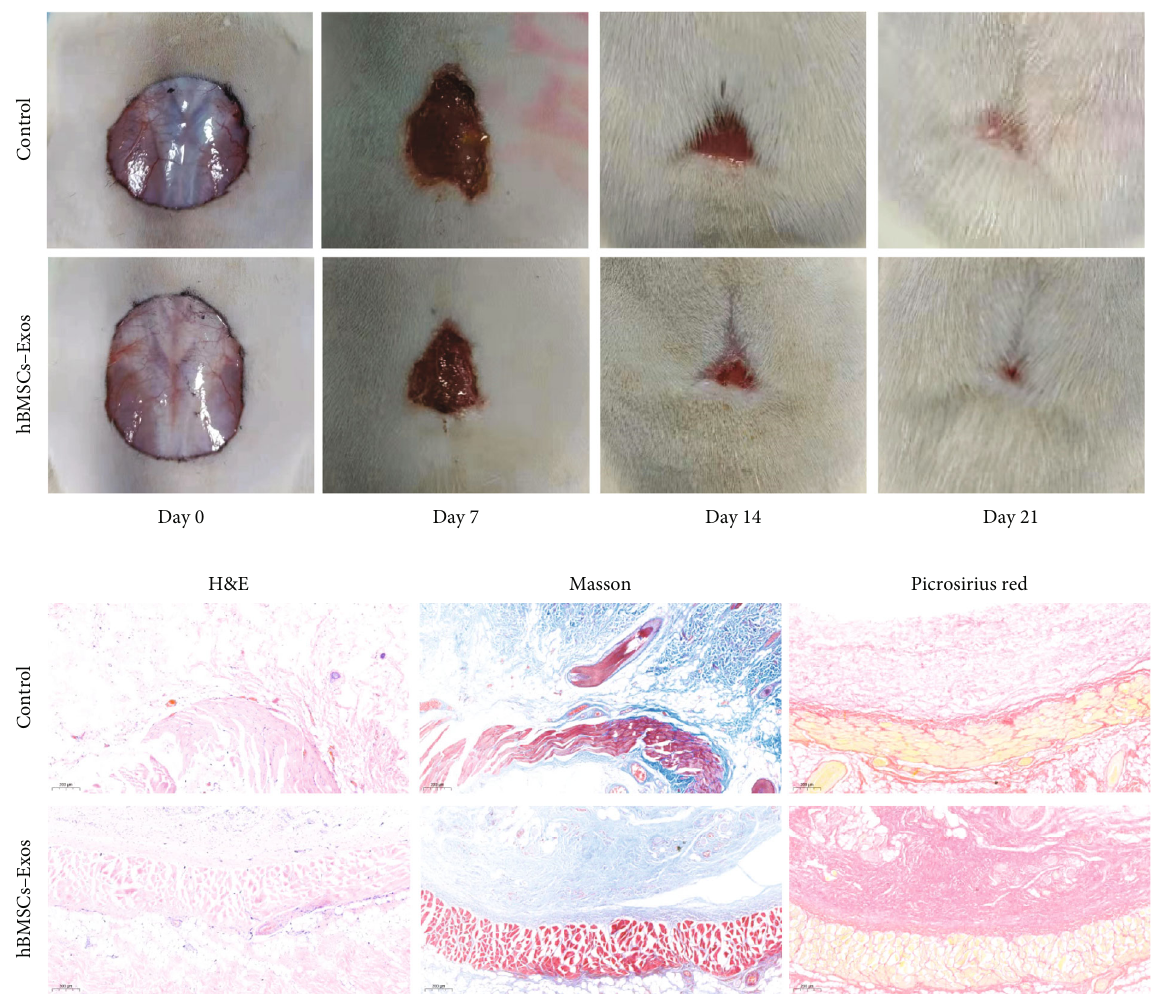
Figure 4: The representative photos shown of full-thickness excision wound area of the rat treated with PBS (control) or hBMSCs-Exos. Reproduced with from Ref. [69]. Copyright 2021 BioMed Central